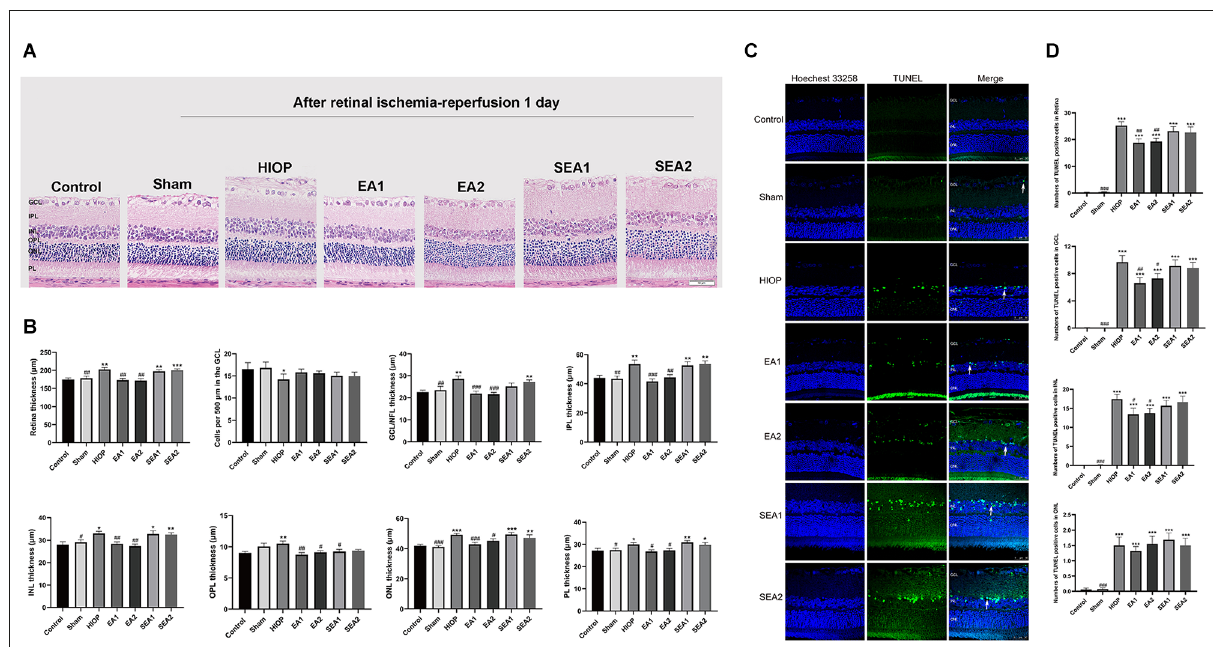
FIGURE3 EA can ameliorate injury and apoptosis of the retina at 1 day of RIRI in rats. (A) H&E staining of retinal cross-sections showed the retinal tissue thickness of ischemia-reperfusion (I/R) rats in every group at 1 day of reperfusion. GCL, ganglion cell layer; INL, inner nuclear layer; IPL, inner plexiform layer; ONL, outer nuclear layer; OPL, outer plexiform layer; PL, photoreceptor layer (scale bar: 50 µ m.). (B) Measurement of retinal thickness from the ganglion cell layer (GCL) to the photoreceptor layer (PL); the number of cells per 500 µ m in the GCL and the mean thicknesses of different retinal layers at 1 day of RIRI in rats are shown. (C) Apoptotic cells were detected by TUNEL assay in retinal sections at 1 day of RIRI in rats. Representative images of TUNEL-positive cells (green) are shown. The nuclei were counterstained with Hoechst 33342 (blue). Scale bar: 50 µ m. (D) Bar graphs showing the average number of TUNEL-positive cells in the GCL, ONL, INL, and entire retina. The data are presented as the mean ± SEM (* P < 0.05, ** P < 0.01, *** P < 0.001 vs. the control group; # p < 0.05, ## P < 0.01, ### P < 0.001 vs. the HIOP group; n = 5 for each group). EA,